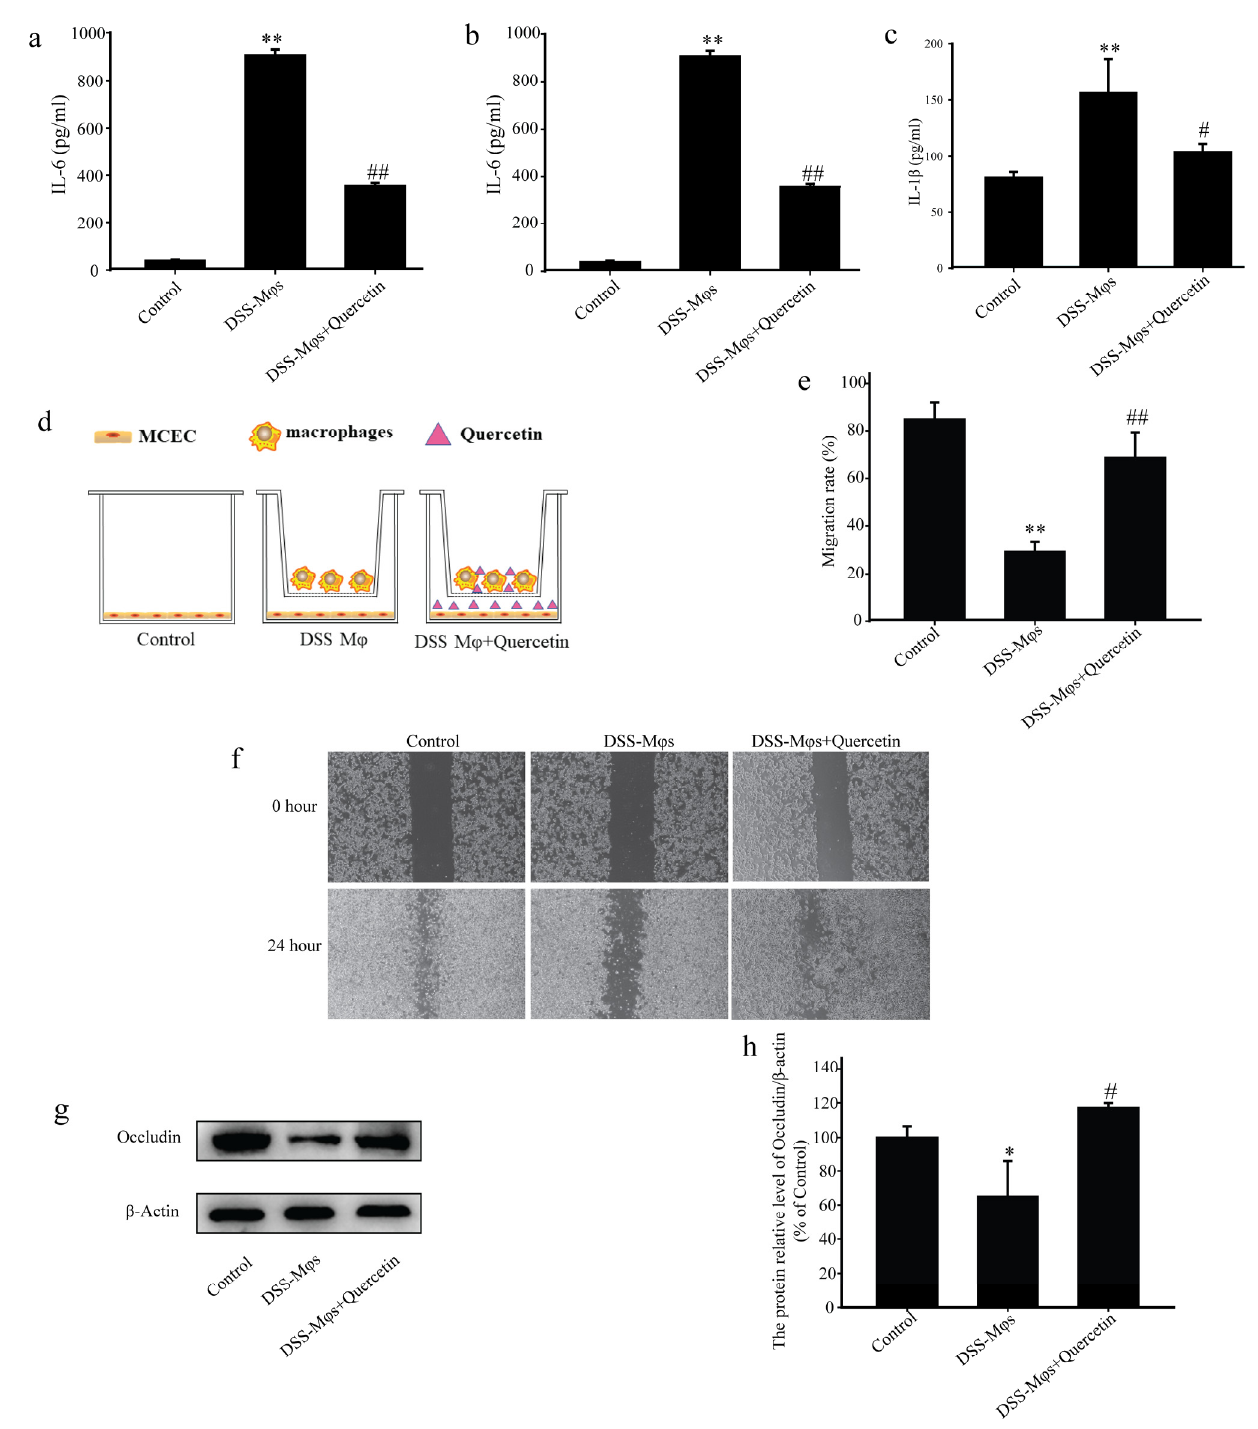
Figure 7. Quercetin suppressed inflammation and contributed to mucosal healing. Analysis of the concentrations of interleukin (IL)-6 ( a ), tumor necrosis factor (TNF)- α ( b ), and IL-1 β ( c ) using an enzyme-linked immunosorbent assay. ( d – f ) Scratch assay showing the migration capacity of mouse colon epithelial cells (MCECs) co-cultured in vitro with macrophages under quercetin treatment. ( g , h ) Western blotting analysis of occludin expression in extracts of MCECs. * p < 0.05, ** p < 0.01 compared with the control group; # p < 0.05, ## p < 0.01 compared with the DSS group. In scratch experiments on the co-culture system, the capacity of MCECs to migrate was decreased in the presence of M φ s from DSS mice, in contrast to the promotion of MCEC migration by M φ s with quercetin-treated cells (Figure 7d–f). Western blot analysis